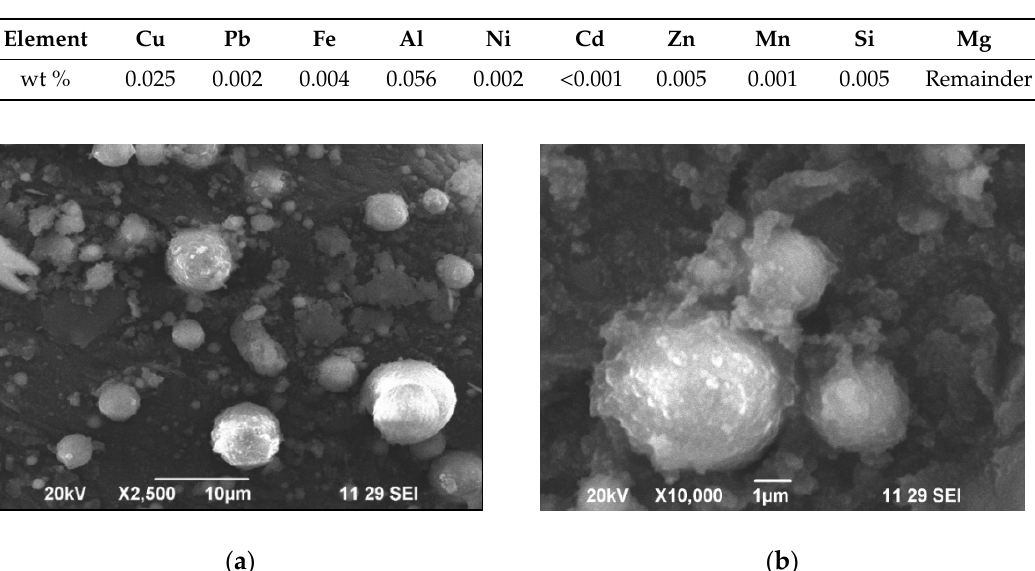
Table 1. Elemental composition of pure magnesium (wt %).